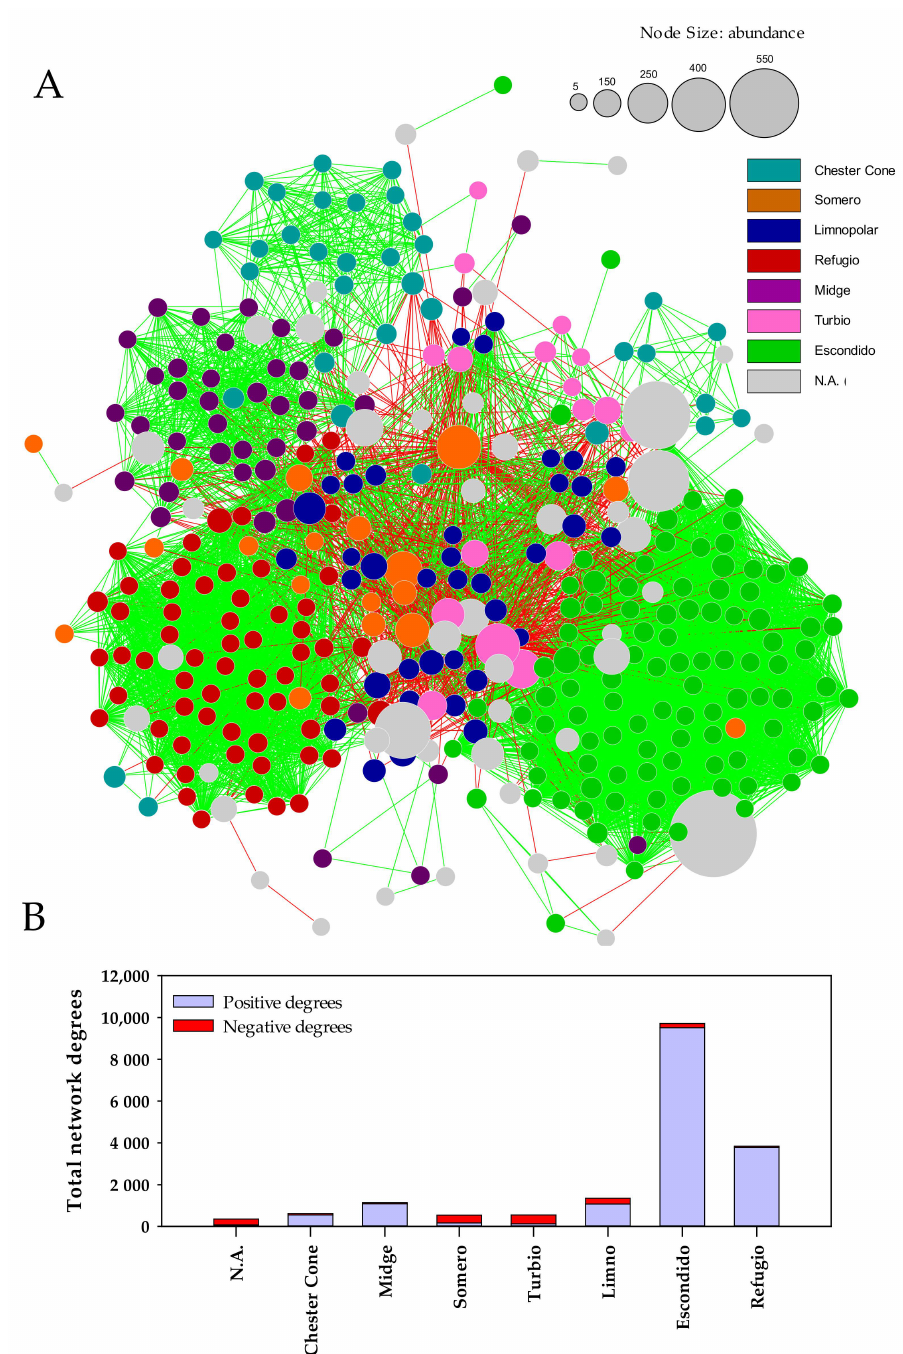
Figure 7. ( A ) Bacterioplankton co-occurrence network of the Antarctic lakes studied, based on the relative abundance matrix previously reported by Picazo et al. [4]. The nodes represent ZOTUs sequences. The size of the node indicates the relative (rarefied) abundance, and the color of the nodes indicates the level of specificity of ZOTUs for a certain lake, in such way that when at least 90% of reads are associated to a single lake, the node of the ZOTU shows the same color of the lake indicated in the legend for the lake. Nodes with significantly positive or negative co-occurrence for any of five measures used (Pearson correlation, Spearman correlation, Bray–Curtis dissimilarity, Kullback–Leiber dissimilarity, and mutual information similarity) are joined with a single edge. ( B ) Total network degrees obtained in the co-occurrence analysis for each of the studied lakes distinguishing the positive and negative relationships between nodes (ZOTUs). N.A. = ZOTU not assigned specifically to any